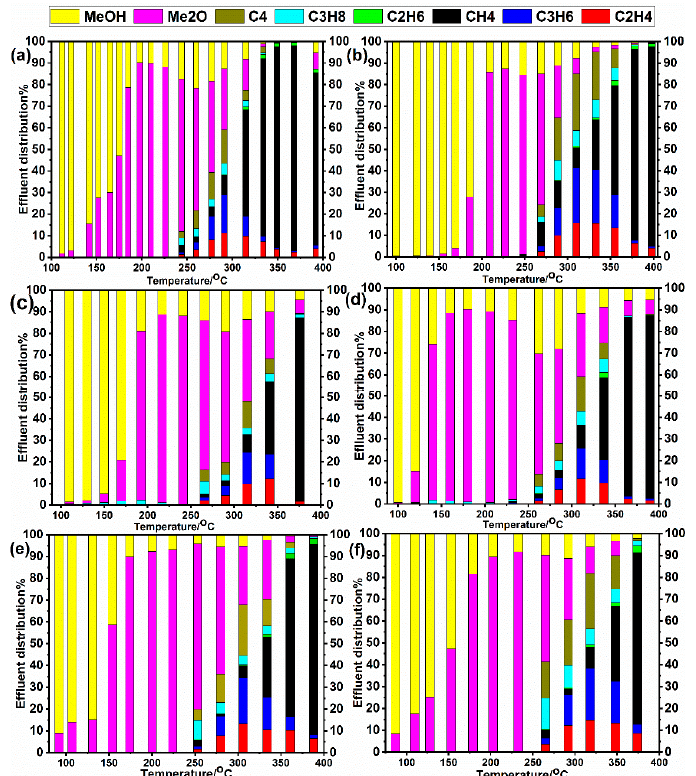
Catalysts 2019 , 9 , x FOR PEER REVIEW